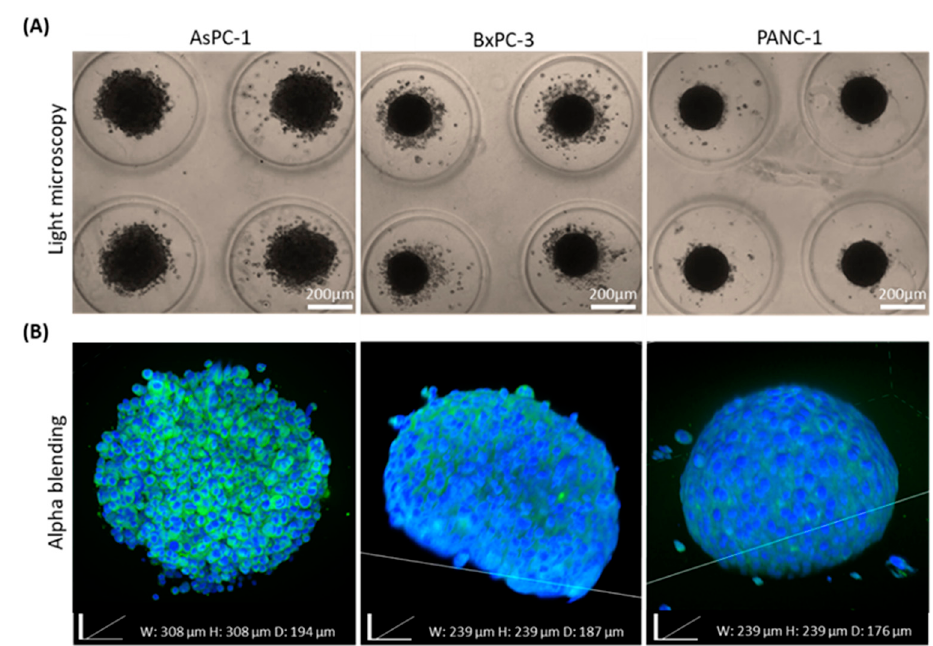
Figure 3. Morphological comparison of pancreatic adenocarcinoma spheroids generated from di ff erent origins. ( A ) Light microscopy bright field images of spheroids originated from di ff erent human pancreatic cancer cell lines (AsPC-1, BxPC-3, and PANC-1). ( B ) Corresponding fluorescence stack images of 3D spheroids stained with DAPI (blue) and Coumarin-6 (green) using confocal microscopy.